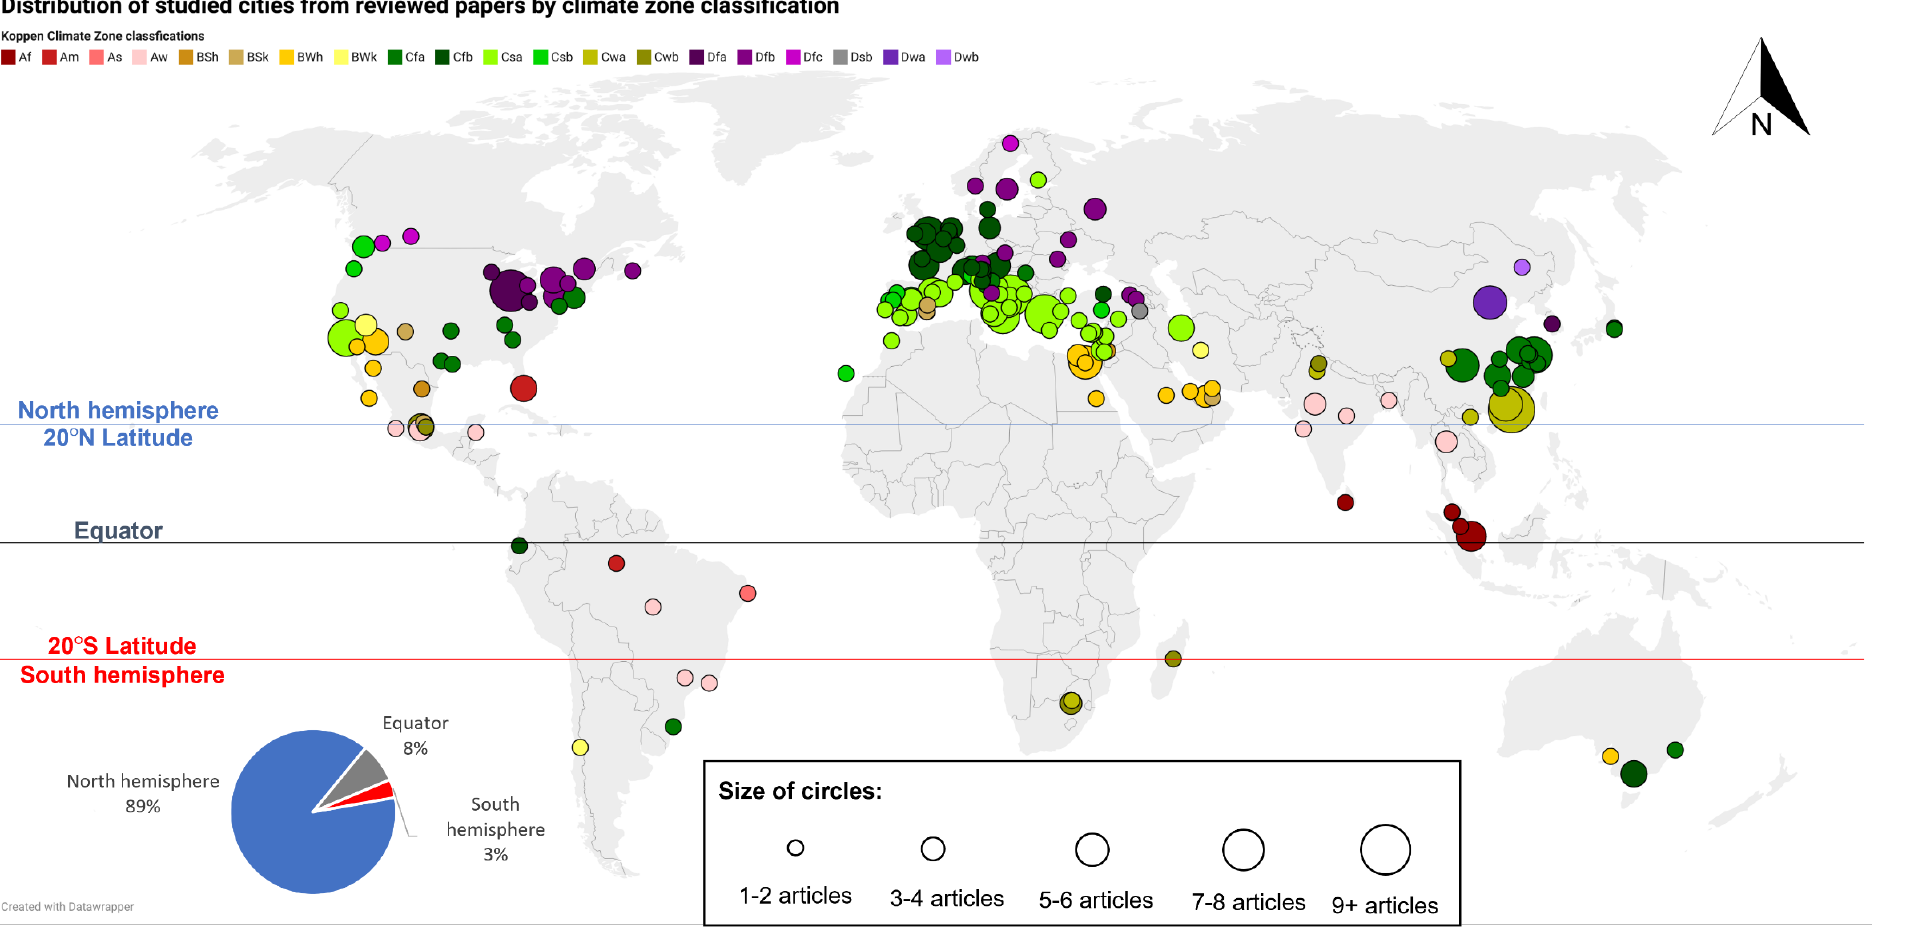
Figure 4. The world map illustrating the distribution of the studied cities in the reviewed papers, according to the updated Köppen-Geiger climate classification scheme in 2016 (see Appendix C for a detailed explanation of the Köppen-Geiger climate classification scheme) [46]. In this paper, the area above the 20° N latitude line is considered to be the northern hemisphere, while the area below the 20° S latitude line is considered to be the southern hemisphere; between the two is considered the equatorial region. Map edited using Datawrapper website. Available online: https://www.datawrapper.de/ (accessed on 7 May 2022).